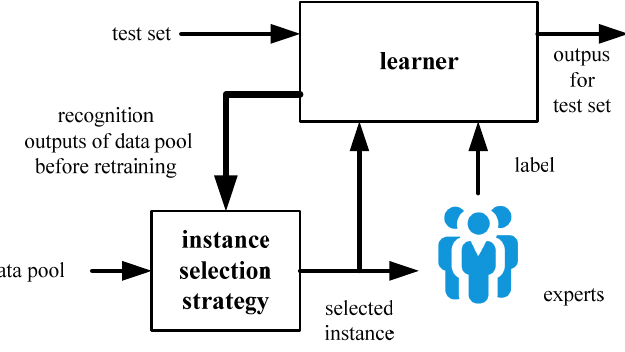
Figure 1. Diagram of active learning.